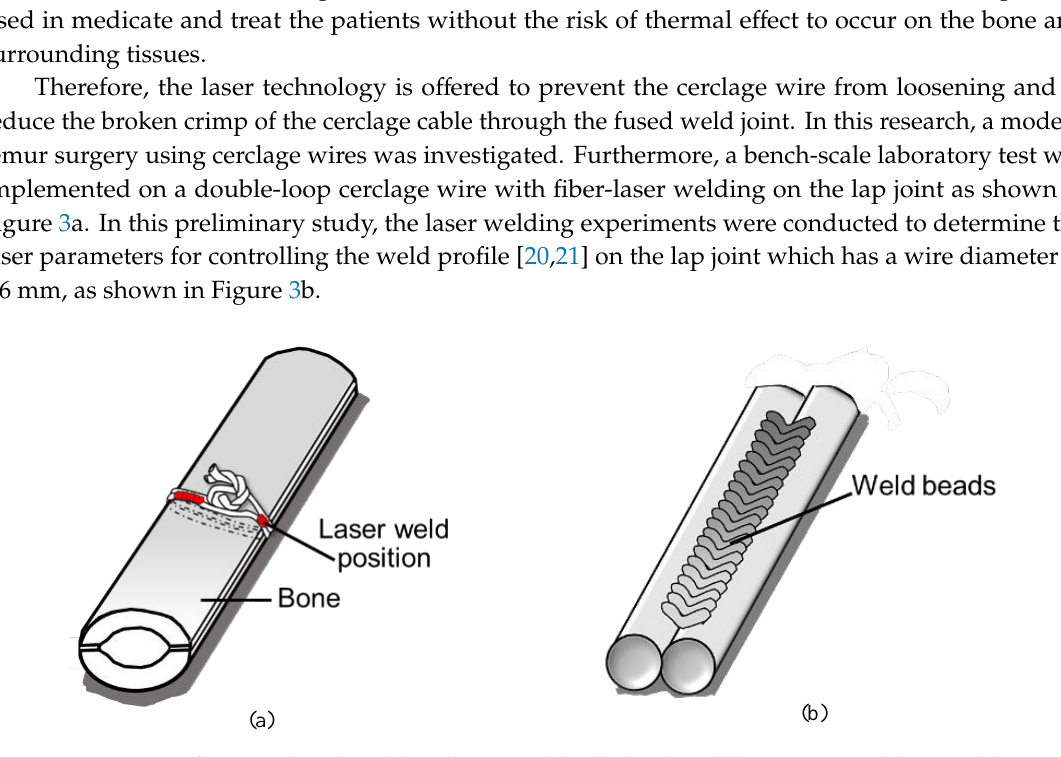
Figure 3. Type of proposed cerclage ( a ) cerclage wire (double loop) and ( b ) specimen with laser welding.